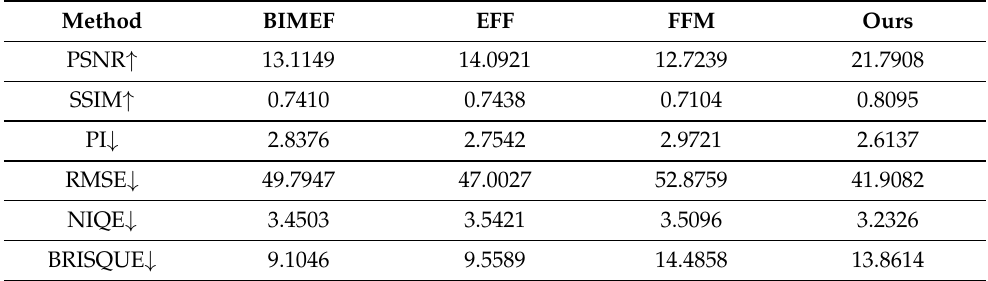
Table 2. Average performance of different enhancement methods in Figure